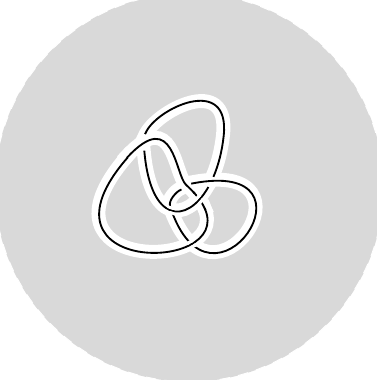
Figure 2 . The link complement (the shaded region) of a 3-component link (bold lines) inside the three-sphere. The white region indicates a tubular neighbourhood of the link which has been drilled out of the